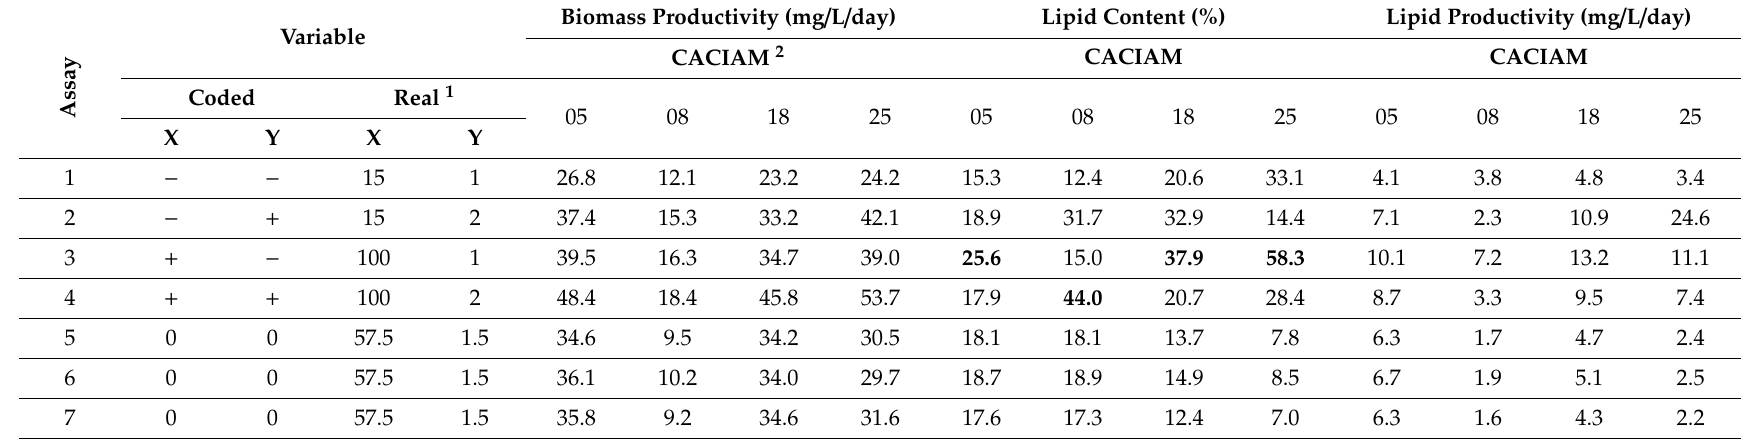
Table 1. Experimental matrix and results obtained from the experimental design (2 2 ) used to optimize the independent variables, light intensity (X), and concentration of NaNO 3 (Y) in the culture